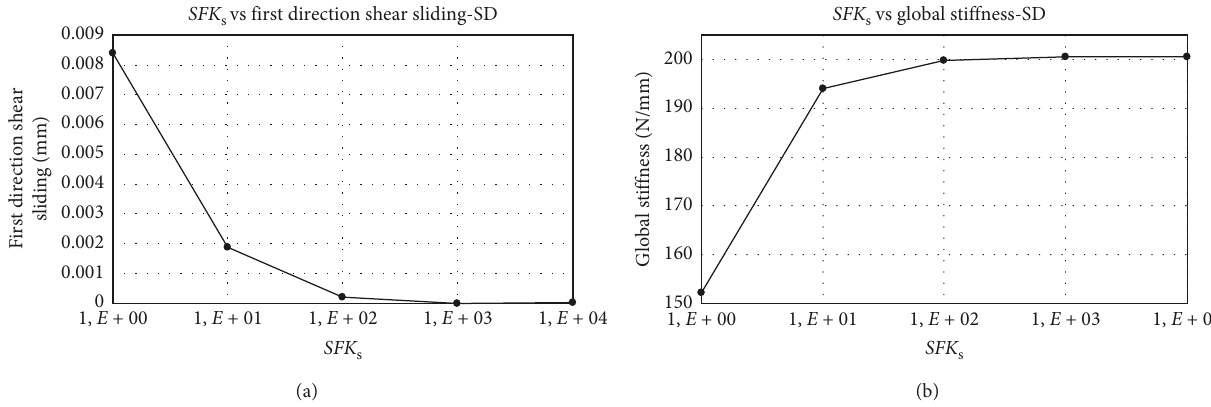
Figure 8: Sliding in first shear direction (a) and global stiffness (b) as a function of k